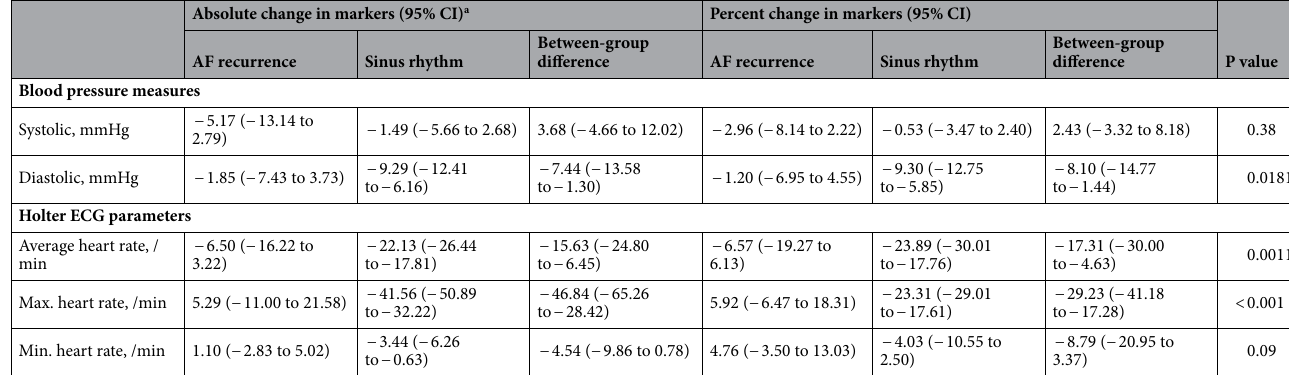
Table 4. Changes in clinical measures by rhythm status at follow-up. a Mean difference with corresponding 95% confidence intervals. P value compares mean differences of biomarkers between AF recurrence and sinus rhythm patients and are calculated using 2-sample t